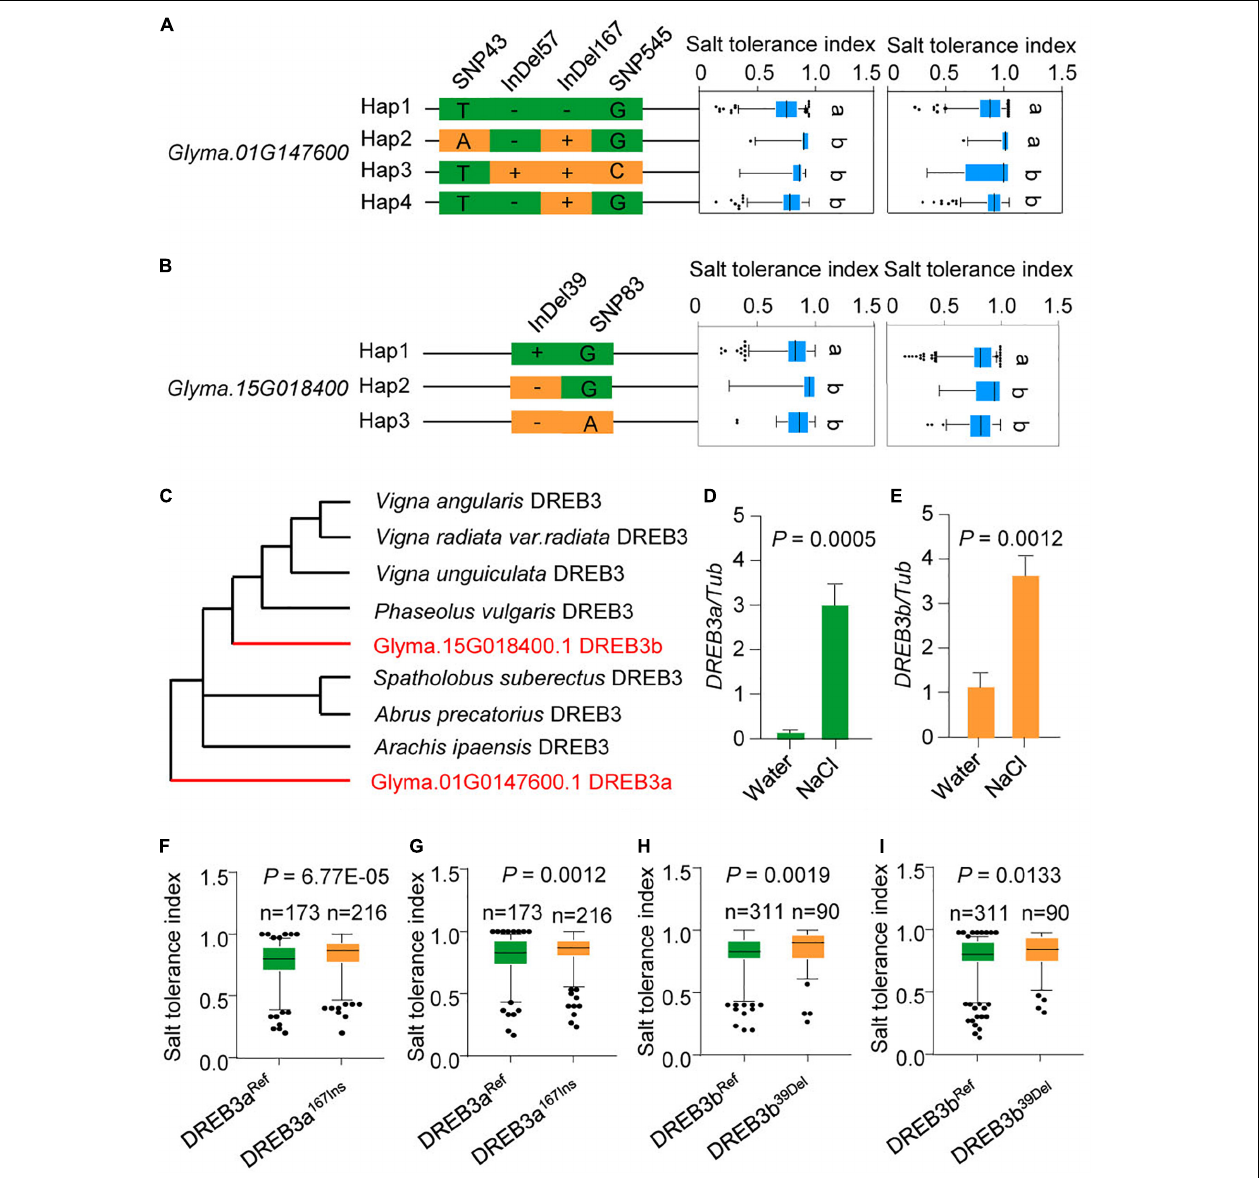
FIGURE 4 | Natural variation of DREB3a and DREB3b are significantly associated with the salt tolerance. (A) Boxplots for salt tolerance index based on the haplotypes of Glyma.01G147600 among 424 soybean accessions. The Glyma.01G147600 haplotypes (Hap1–Hap4) were categorized by the four significant variants. (B) Boxplots for salt tolerance index based on the haplotypes of Glyma.15G018400 among 424 soybean accessions. The Glyma.15G018400 haplotypes (Hap1–Hap3) were categorized by the two significant variants. The experiment was performed using two biological replicates in (A,B) . The same lowercase letters above the histogram bars in (A,B) denote non-significant differences across the two panels ( P > 0.05). One-way ANOVA was used to generate the P -values. (C) Phylogenetic tree of DREB proteins in plants. Red indicates DREB3a and DREB3b protein. (D) The transcription levels of DREB3a under salt stress (200 mM NaCl). (E) The transcript levels of DREB3b under salt stress (200 mM NaCl). All data were given as mean ± s.e.m. ( n = 3 biological replicates). (F,G) GmDREB3a Ref and DREB3a 167 Ins alleles associated with salt tolerance index. (H,I) DREB3b Ref and DREB3b 39 Del alleles associated with salt tolerance index. One-tailed Student’s t -test was used to generate the P -values in (D–I)